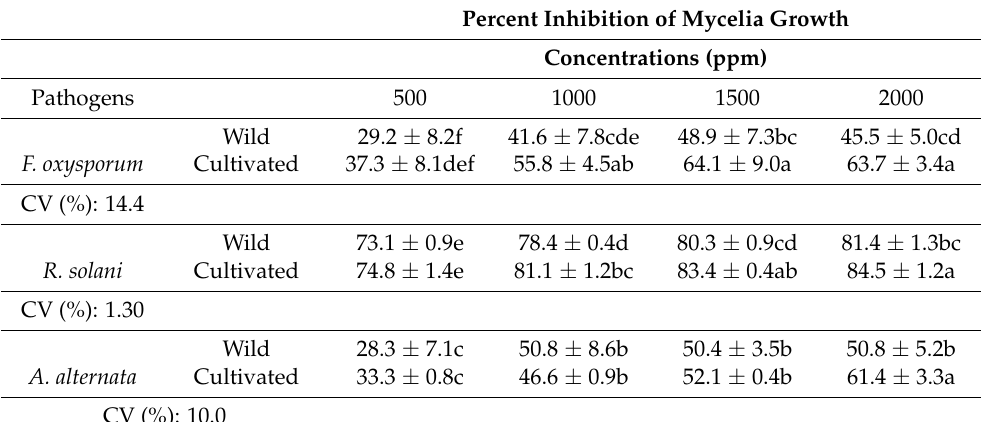
Table 3. Antifungal activity of wild and cultivated E. tenuifolia subsp. sibthorpiana